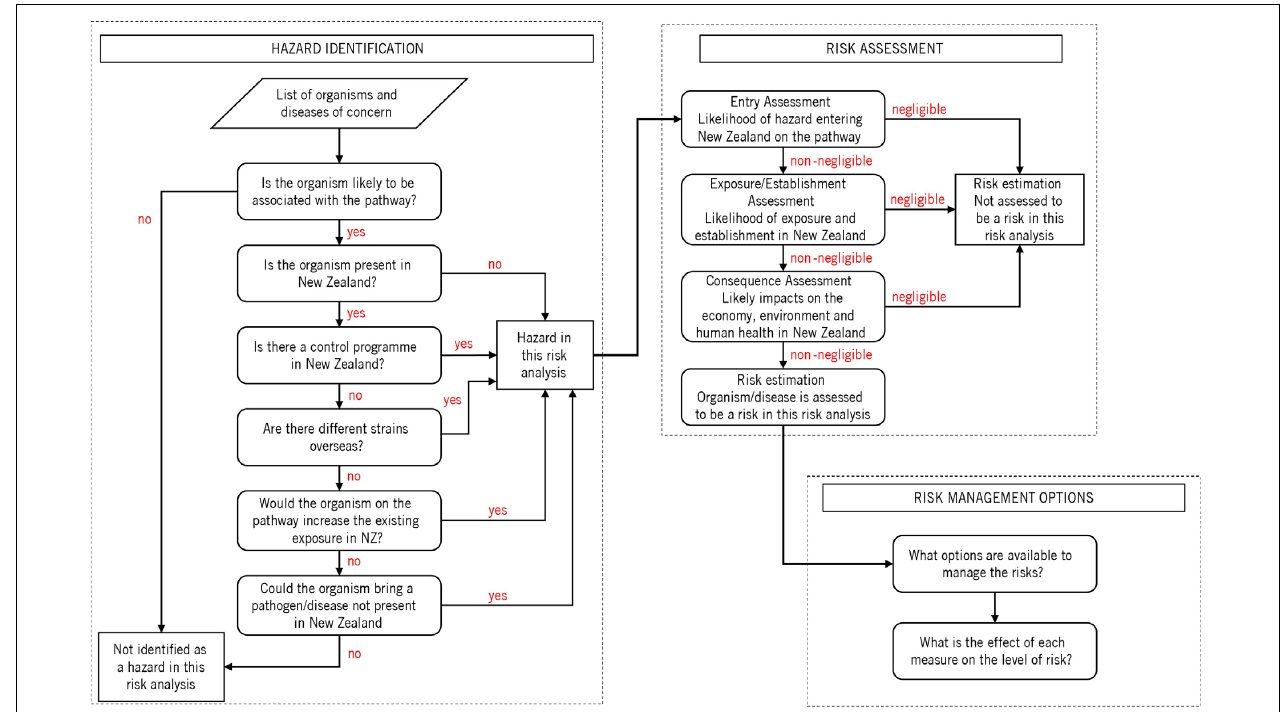
FIGURE 1 | Outline of the risk analysis process (Ministry for Primary Industries New Zealand [MPI], 2006).